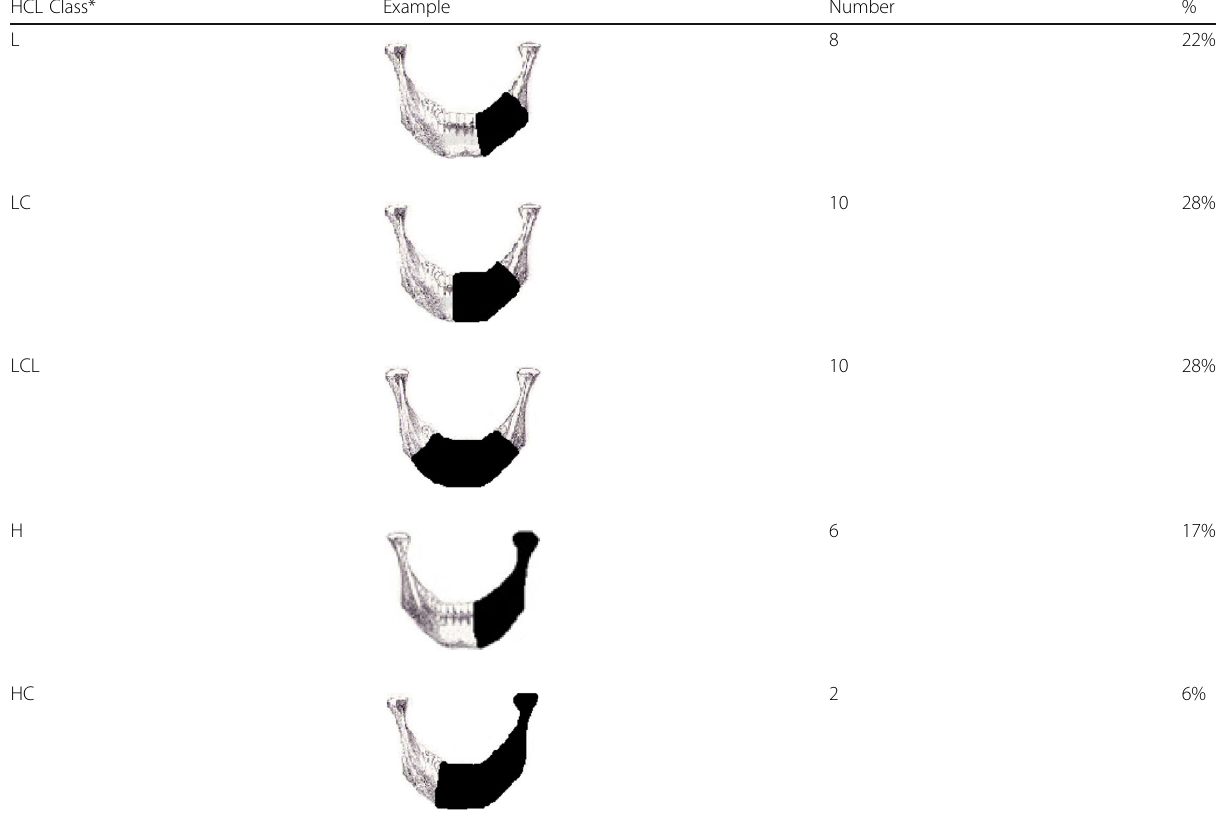
H: represents the same defect but also involving the condyle; C: represents the anterior segment between the incisive foramina; L: represents any lateral defect not involving the condyle and not significantly crossing the